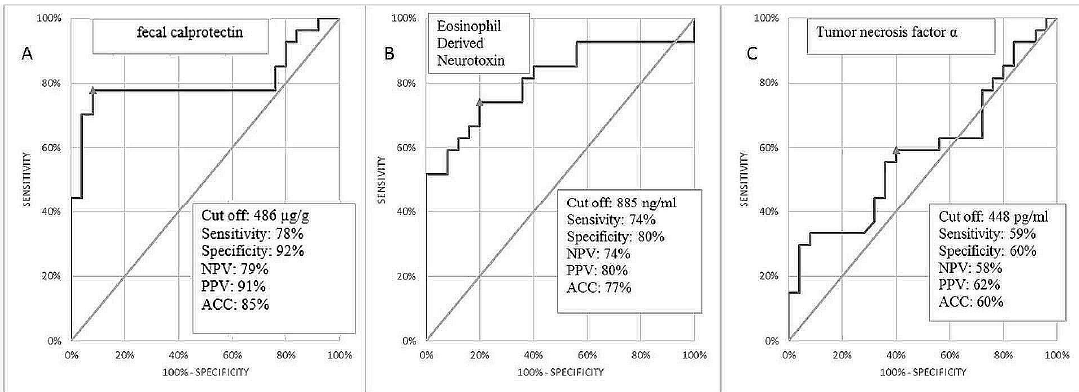
Figure 3. Receiver operating characteristics (ROC) curve of fecal calprotectin ( A ), eosinophil derived neurotoxin ( B ) and TNF α ( C ) for prediction of FPIAP. Abbreviations: NPV, negative predictive values; PPV, positive predictive values; ACC, accuracy.